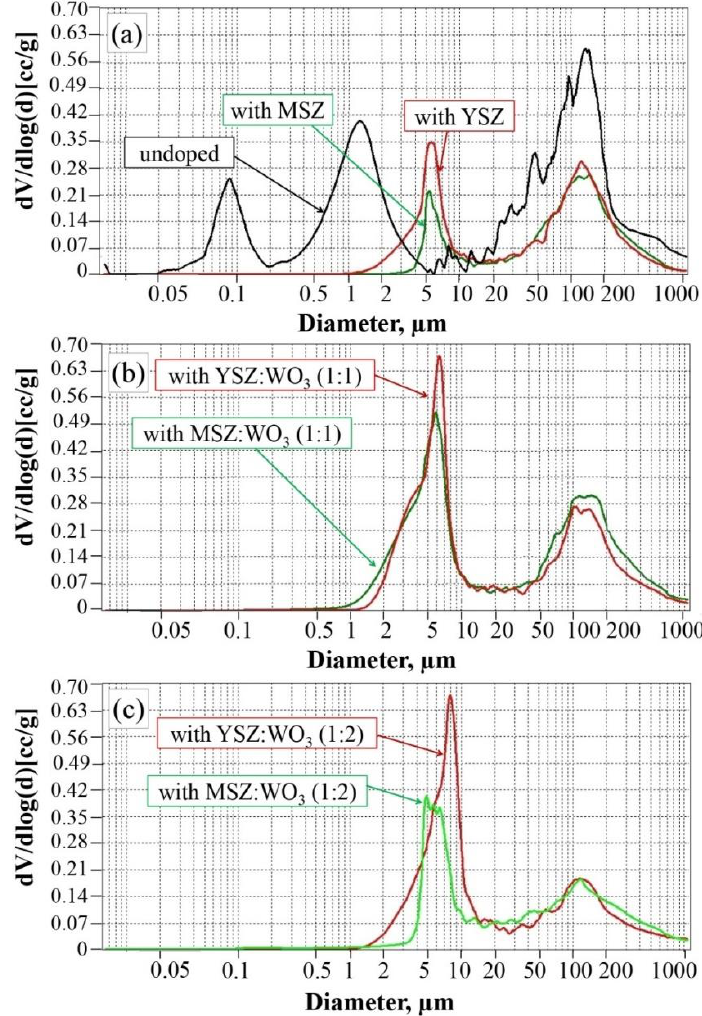
Figure 8. Pore size distributions of the samples: ( a ) undoped samples, with YSZ and with MSZ; ( b ) samples with YSZ:WO 3 (1:1) and with MSZ:WO 3 (1:1); and ( c ) samples with YSZ:WO 3 (1:2) and with MSZ:WO 3 (1:2).